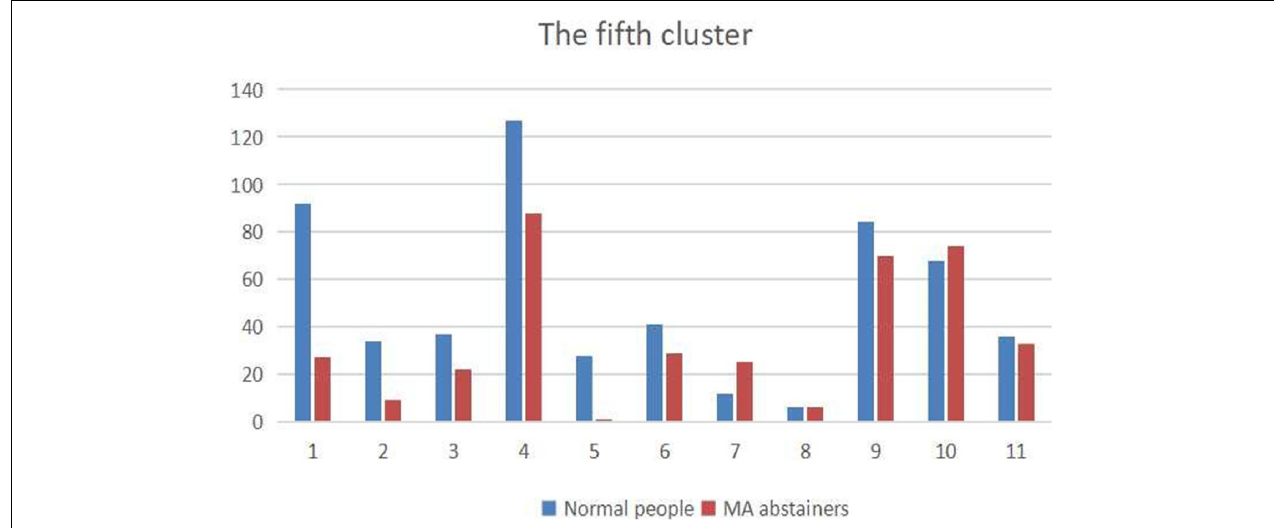
FIGURE 6 | The figure shows the distribution of independent components belonging to the brain networks. The names of the brain networks labeled 1–11 are: ASN, HVN, PSN, DDMN, PN, VDMN, LN, VN, RECN, SN, and AN.